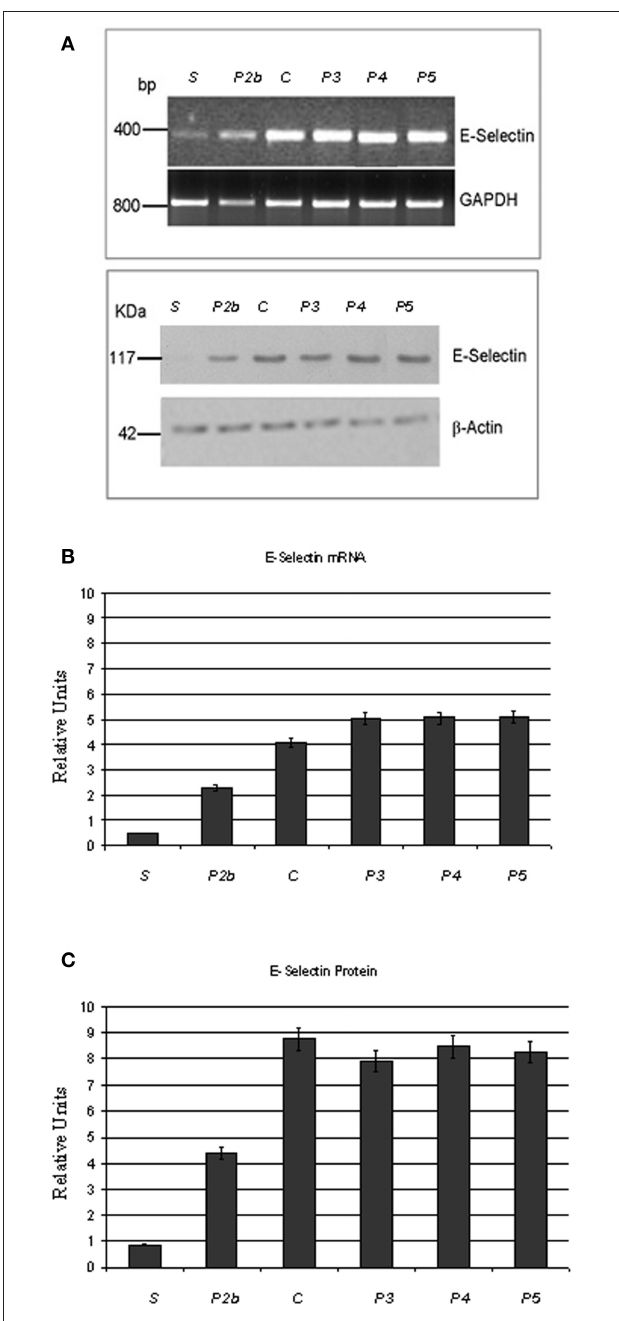
FiGuRE 5 | Treatment with topically applied pLc (2.5 mM/l) reduces the formation of mRNA for E-selectin (upper) and the expression of E-selectin (lower) (A). S , sham-operated; P2b (pLc, 2.5 mM/l, topically applied treated animal); C (I/R control hamster); P3 ( l -NAME plus pLc treated hamster), P4 (Apamin- and Charibdotoxin-treated hamster); P5 ( l -NAME and Apamin and Charibdotoxin plus pLc-treated hamster. The intensity of mRNA